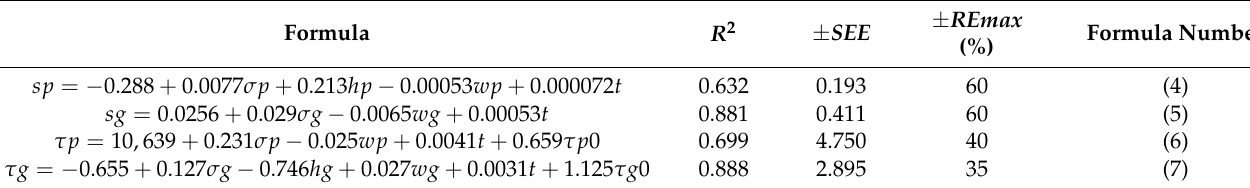
Table 5. Statistical multiple regression